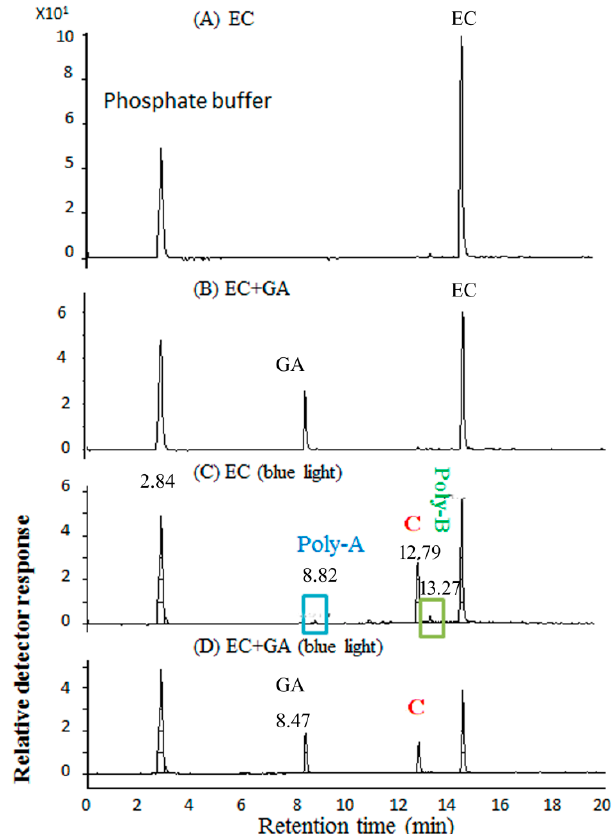
Figure 6. Total ion chromatogram of an HPLC–MS analysis of ( A ) ECPB at pH 8.0 in the dark, ( B ) ECPB treated with GA in the dark, ( C , D ) ECPB treated with blue light illumination at 2.0 mW/cm 2 for 2 h in the absence and presence of GA, respectively.